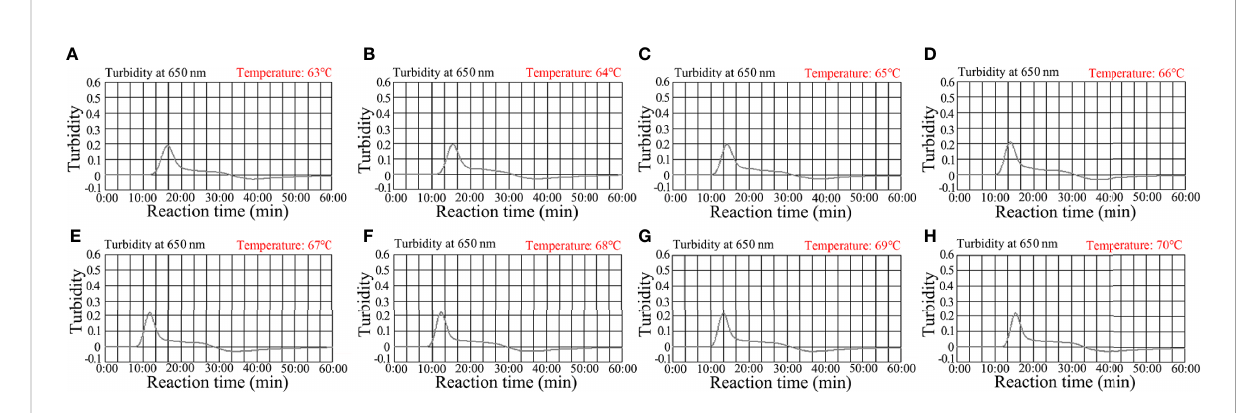
FIGURE 4 Optimizing the temperature for the C. trachomatis -MCDA assay. C. trachomatis -MCDA ampli fi cation of ompA was monitored using real-time turbidity. Corresponding amplicon concentration curves are marked in graphs. Turbidity > 0.1 indicated a positive value. (A – H) Eight kinetic